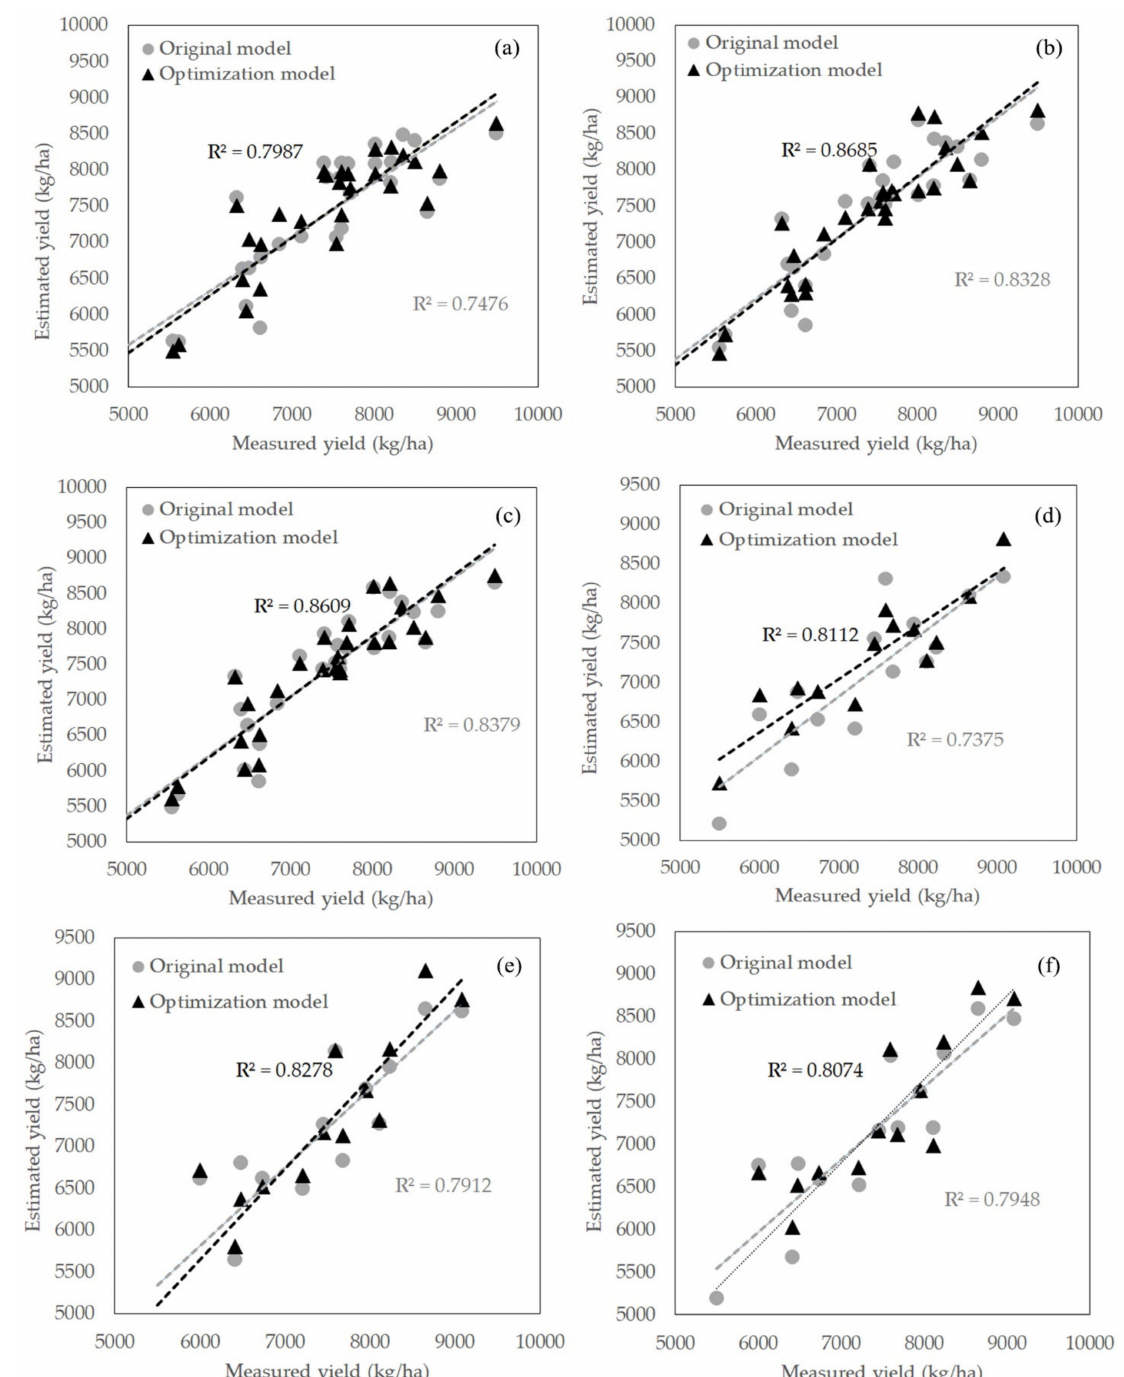
Figure 8. Scatter plots of measured yield vs. estimated yield derived from the original vegetation index-based model and the optimization model introducing florescence spectral information for modeling datasets of ( a ) single growth stage ( b ) two-growth stage ( c ) three-growth stage, and validation datasets of ( d ) single-growth stage ( e ) two-growth stage and ( f ) three-growth